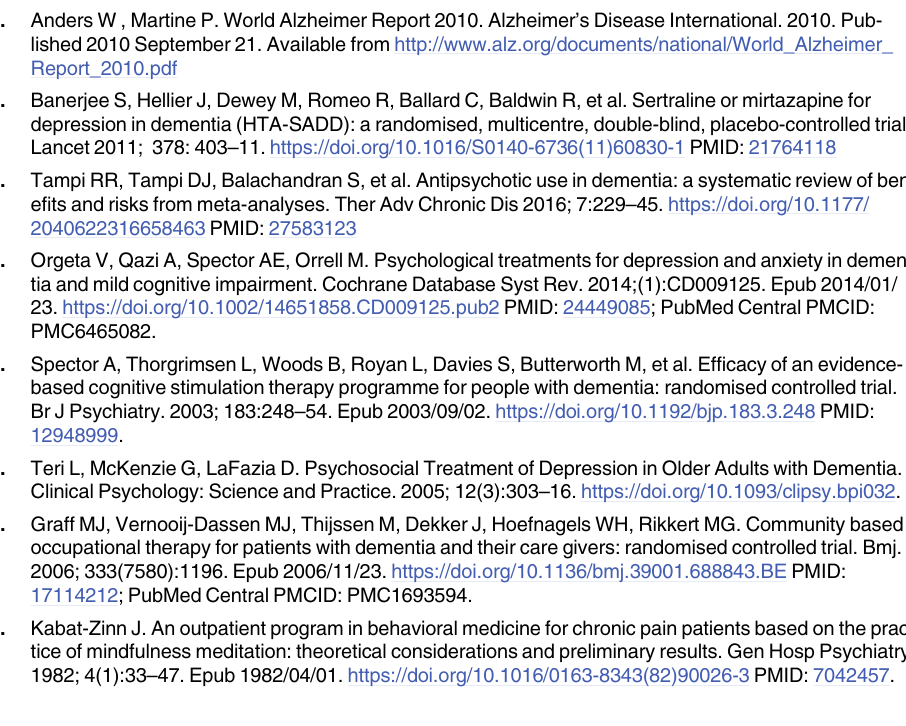
S2 Table. Summary of findings